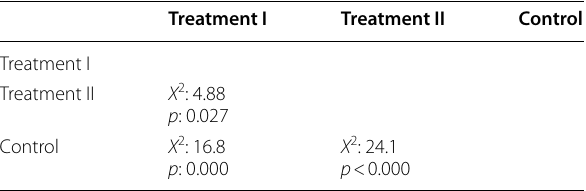
Table 2 Results of long rank test ( X 2 ) for the comparison of the Kaplan–Meier curves of each treatment